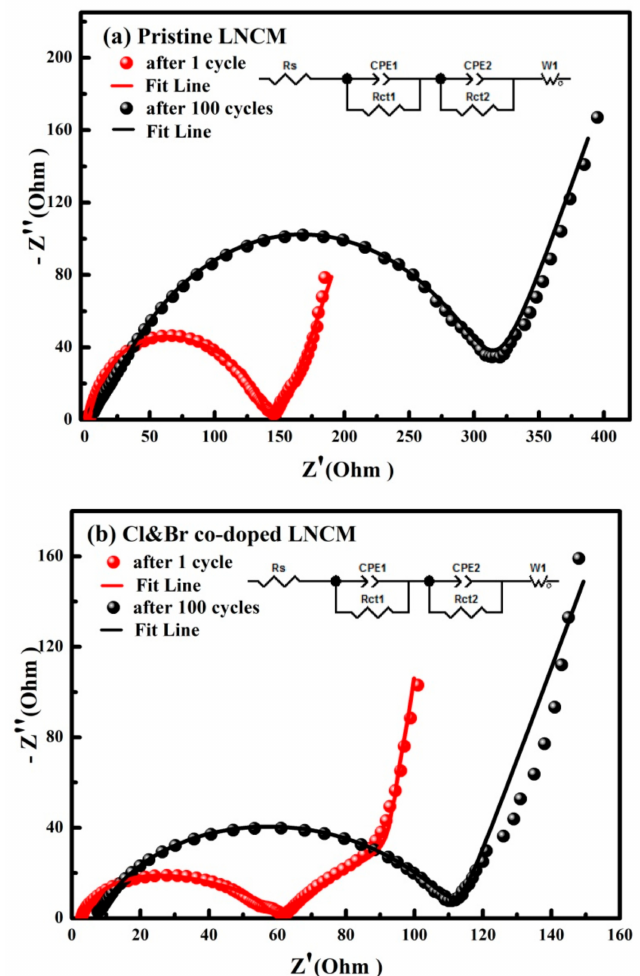
Figure 8. Electrochemical impedance spectra of the synthesized LiNi 1/3 Co 1/3 Mn 1/3 O 2 electrodes after different cycles: ( a ) Pristine LNCM; ( b ) Cl&Br co-doped